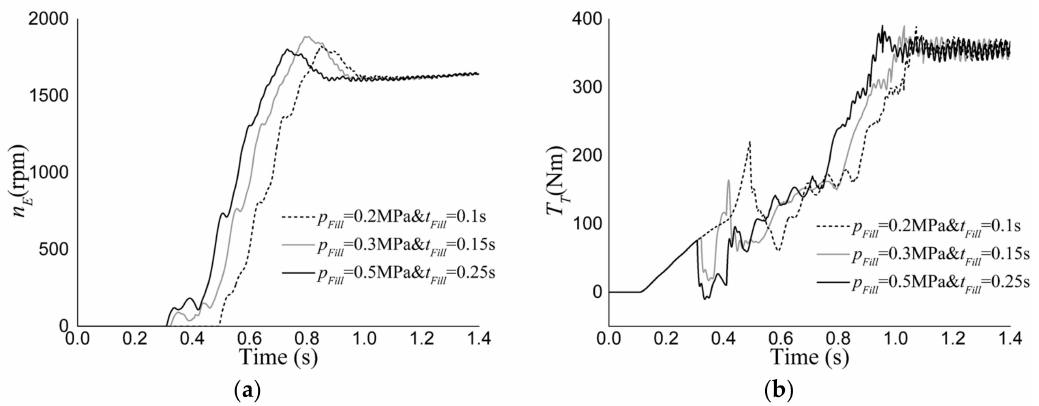
Figure 18. The effect of EDC fill phase on engine speed n E ( a ) and transmission input torque T T ( b